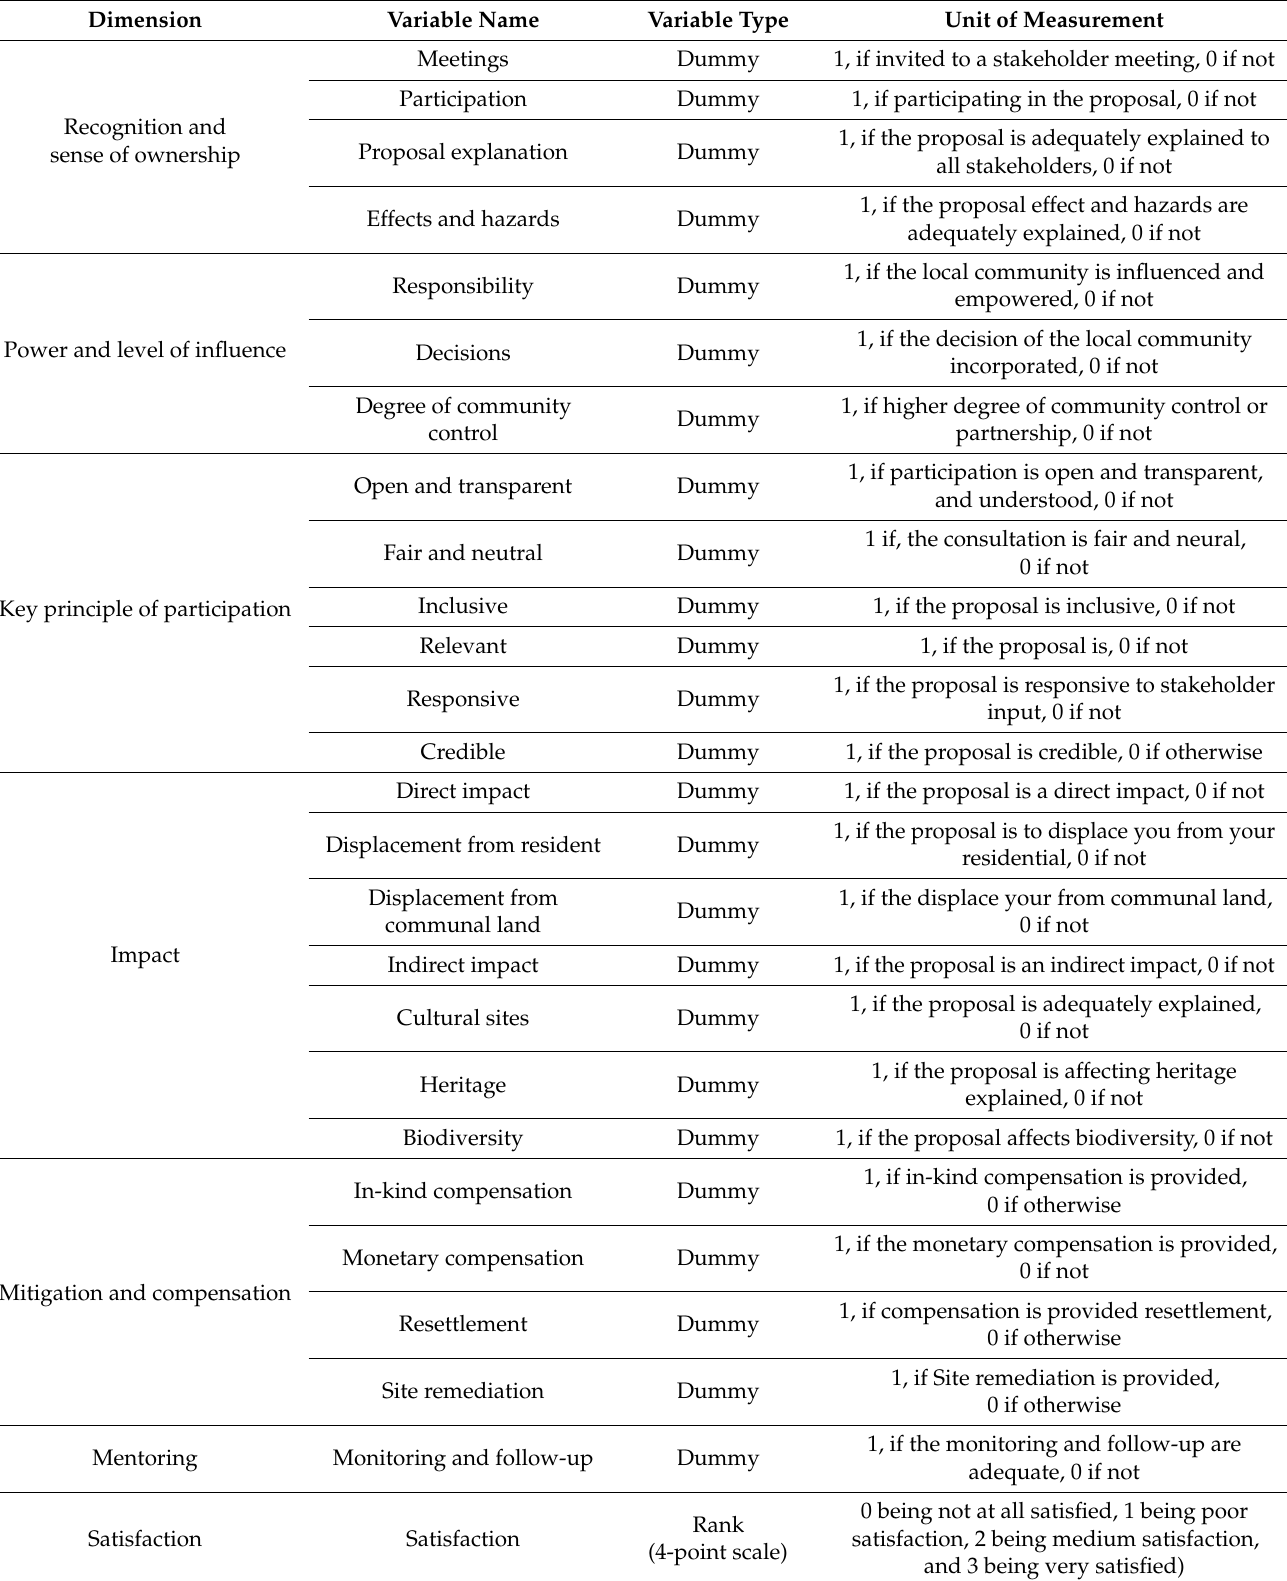
Table 1. List of major variables